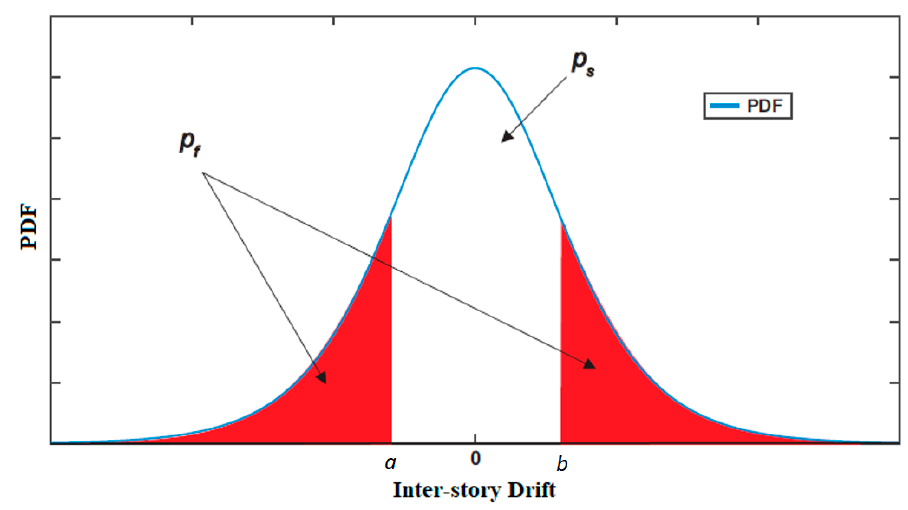
Figure 1. PDF of inter-story drift with limits 𝑎 and 𝑏 .